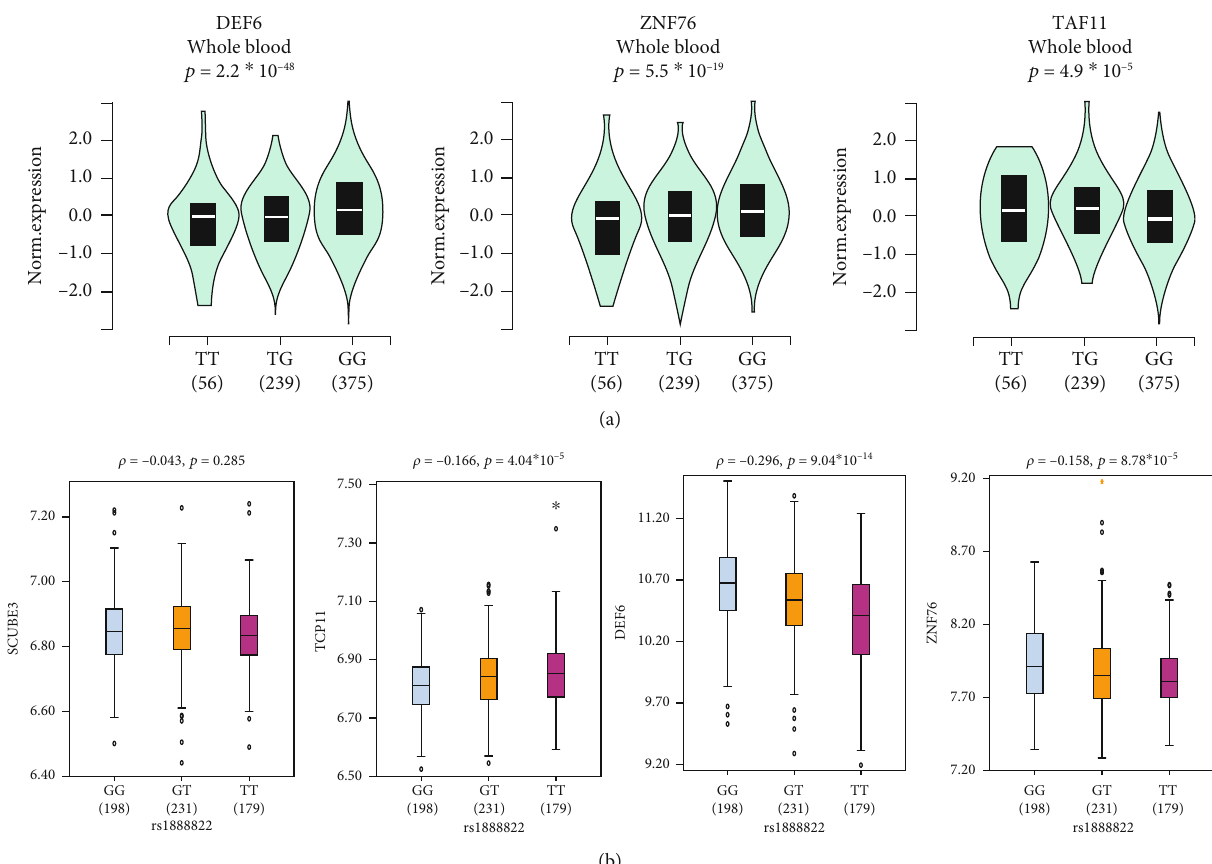
Figure 1: The expression of SCUBE3 in rs188822 genotypes. Data from GTEx study (a) and the integrated analysis of the expression and genotyping data from the HapMap 3 project (b) showed the expression of SCUBE3 in di ff erent rs188822 genotypes.